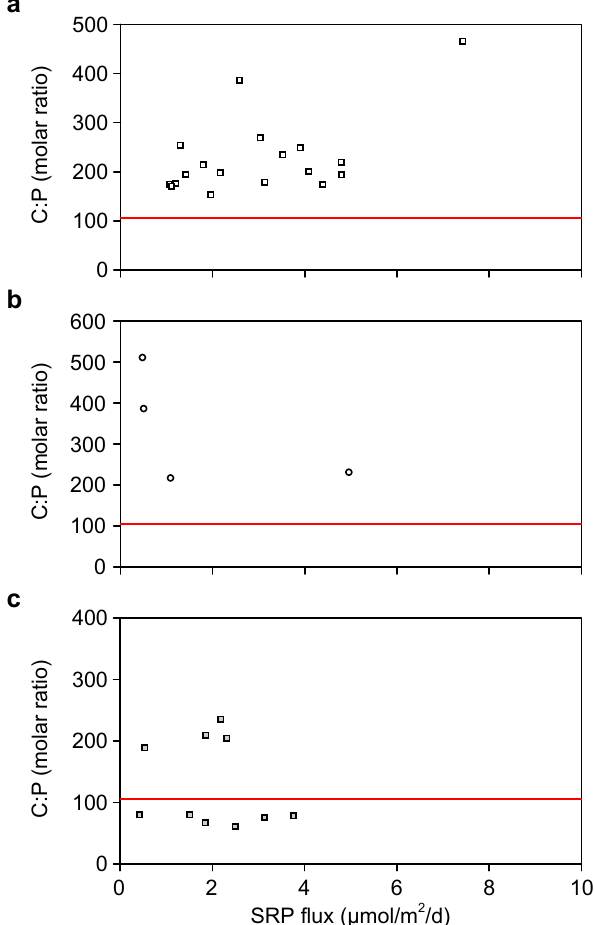
Fig. A4. C:P molar ratio as a function of vertical flux of soluble reactive phosphorus (SRP) from additional cruises in this region across multiple seasons. No significant relationship was detected between C:P ratio and SRP supply (Spearman rank correlations, P>0.05) for cruise (a) X0705 in June 2007 (open squares), (b) BVal39 in October 2007 (open circles), or (c) X0804 in May 2008 (shaded squares). Data for BVal39 were retrieved from the BATS web page (http://bats.bios.edu/) and data for X0705 and X0804 were retrieved from BCO-DMO (http://www.bco-dmo.org). Red line represents Redfield C:P ratio (106).